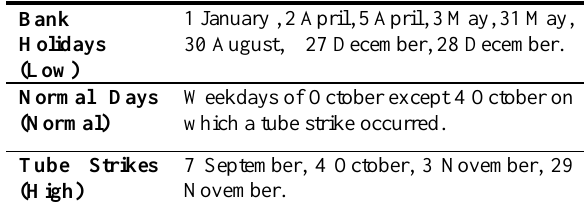
Table 1. The investigated days on three different demand levels